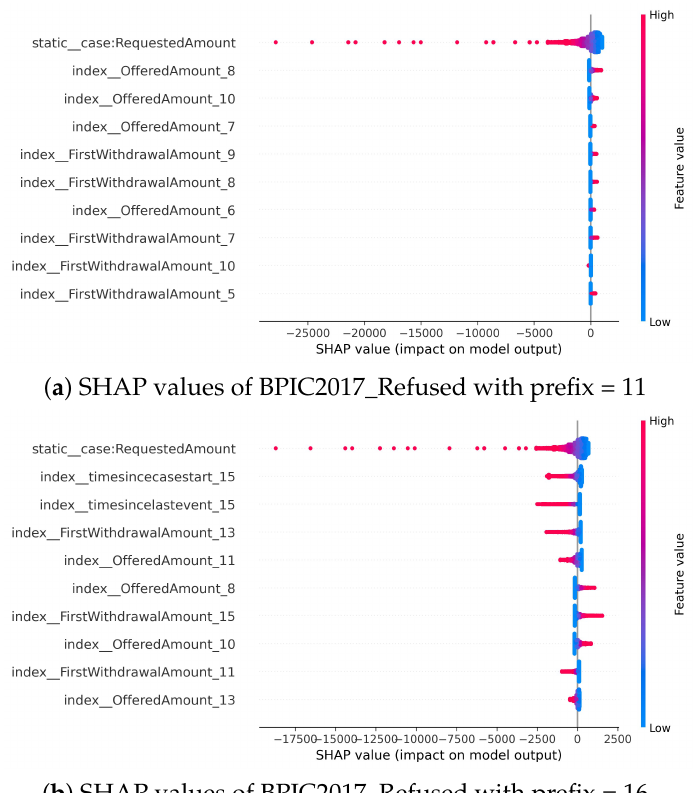
Figure 12. Summary plots of SHAP values of features used by